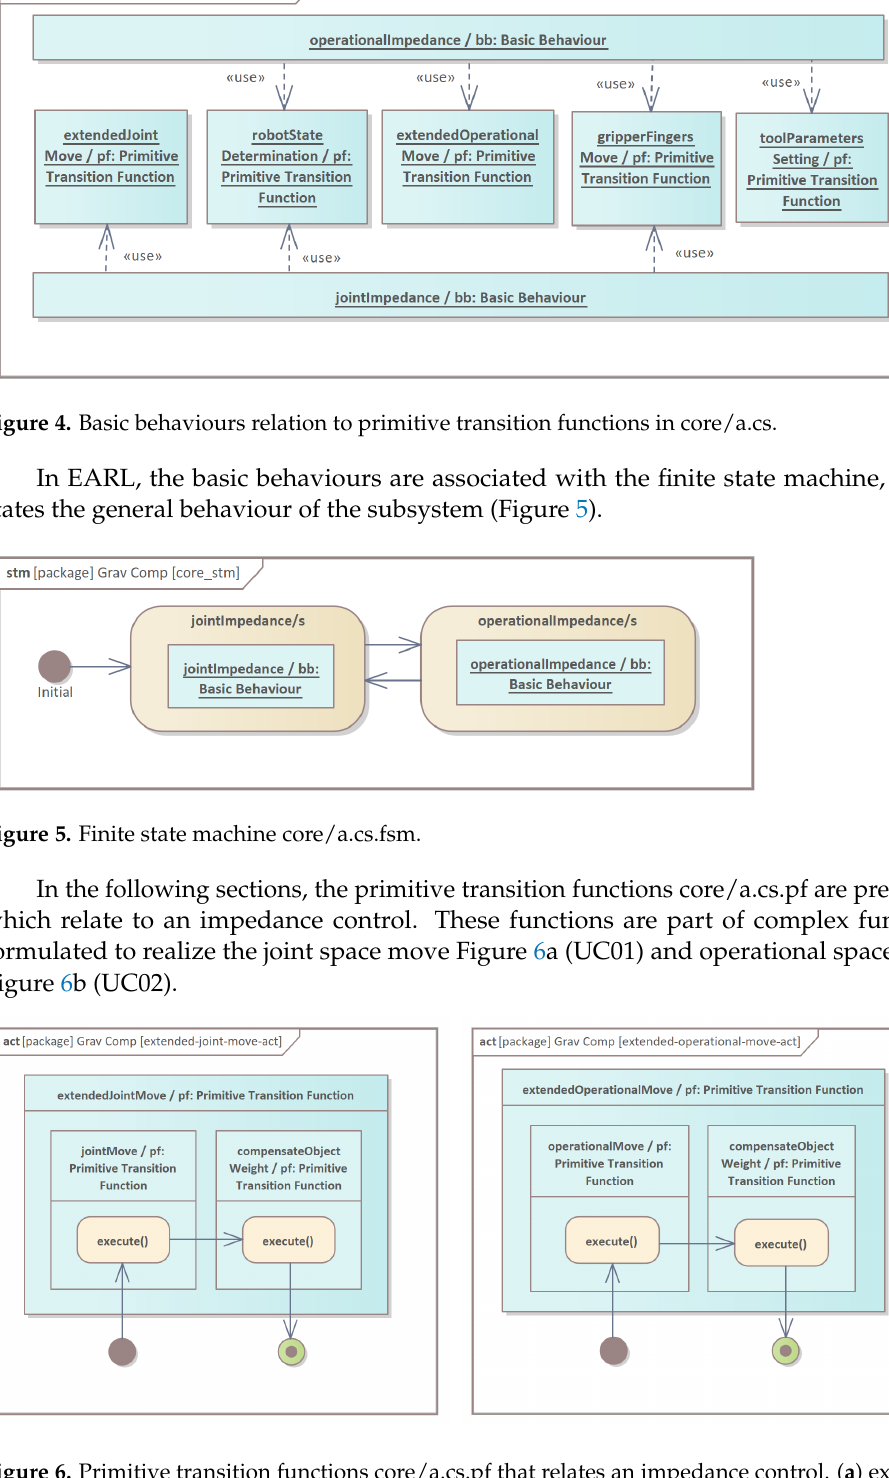
Figure 6. Primitive transition functions core/a.cs.pf that relates an impedance control. ( a ) extended- JointMove/pf. ( b )